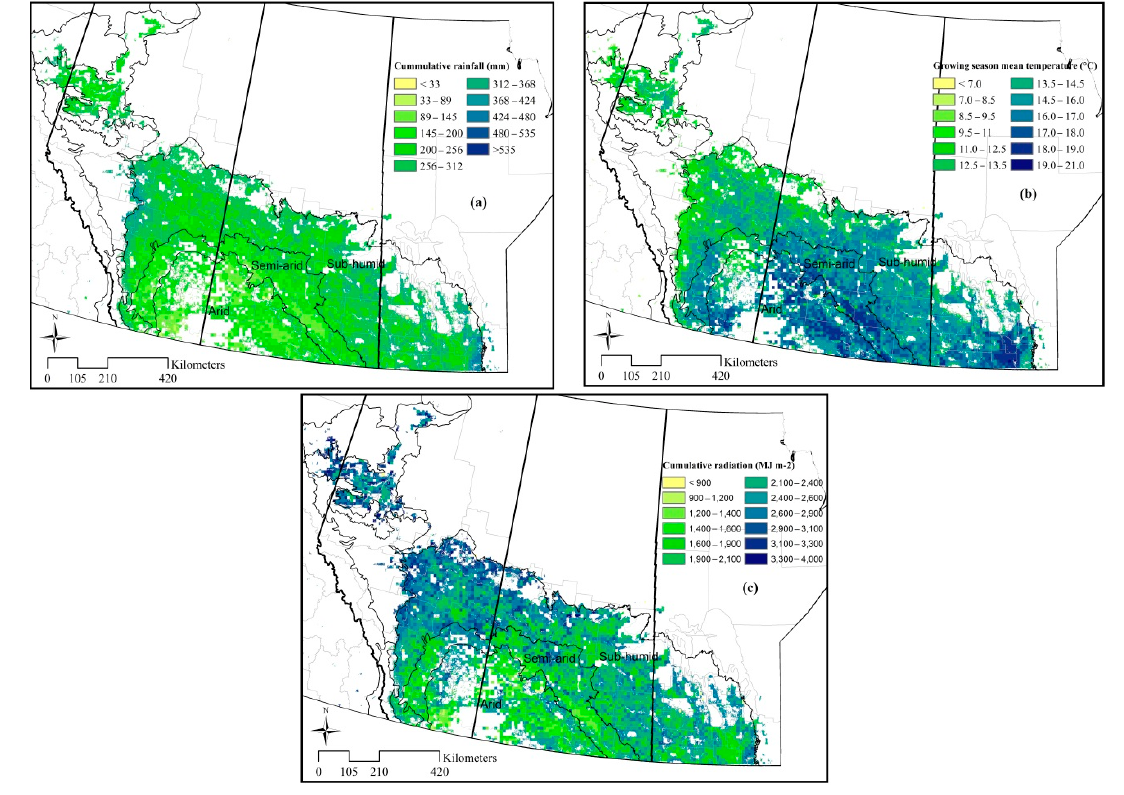
Figure 4. Spatial distribution of climate indices during crop growing seasons from 2000 to 2013 for cumulative rainfall (mm) ( a ); growing season mean temperature (°C) ( b ); and cumulative short wave radiation (MJ·m − 2 ) ( c ), respectively.